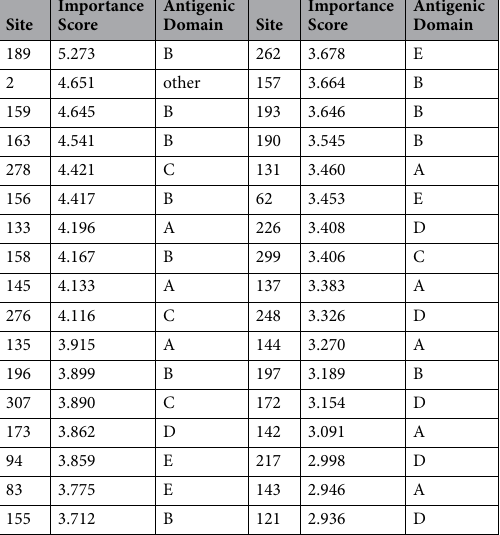
Table 3. The top 34 antigenic importance sites according to importance scoring in JRFR for H3N2 influenza data.